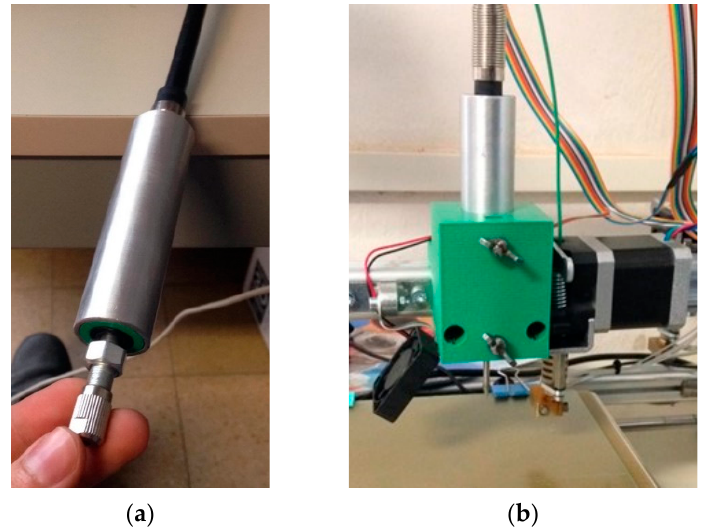
Figure 6. Low-power tool for material removal ( a ) spindle with the flexible shaft; ( b ) installation on the X gantry of the FFF machine. The butterfly screw permits an easy setting of the spindle